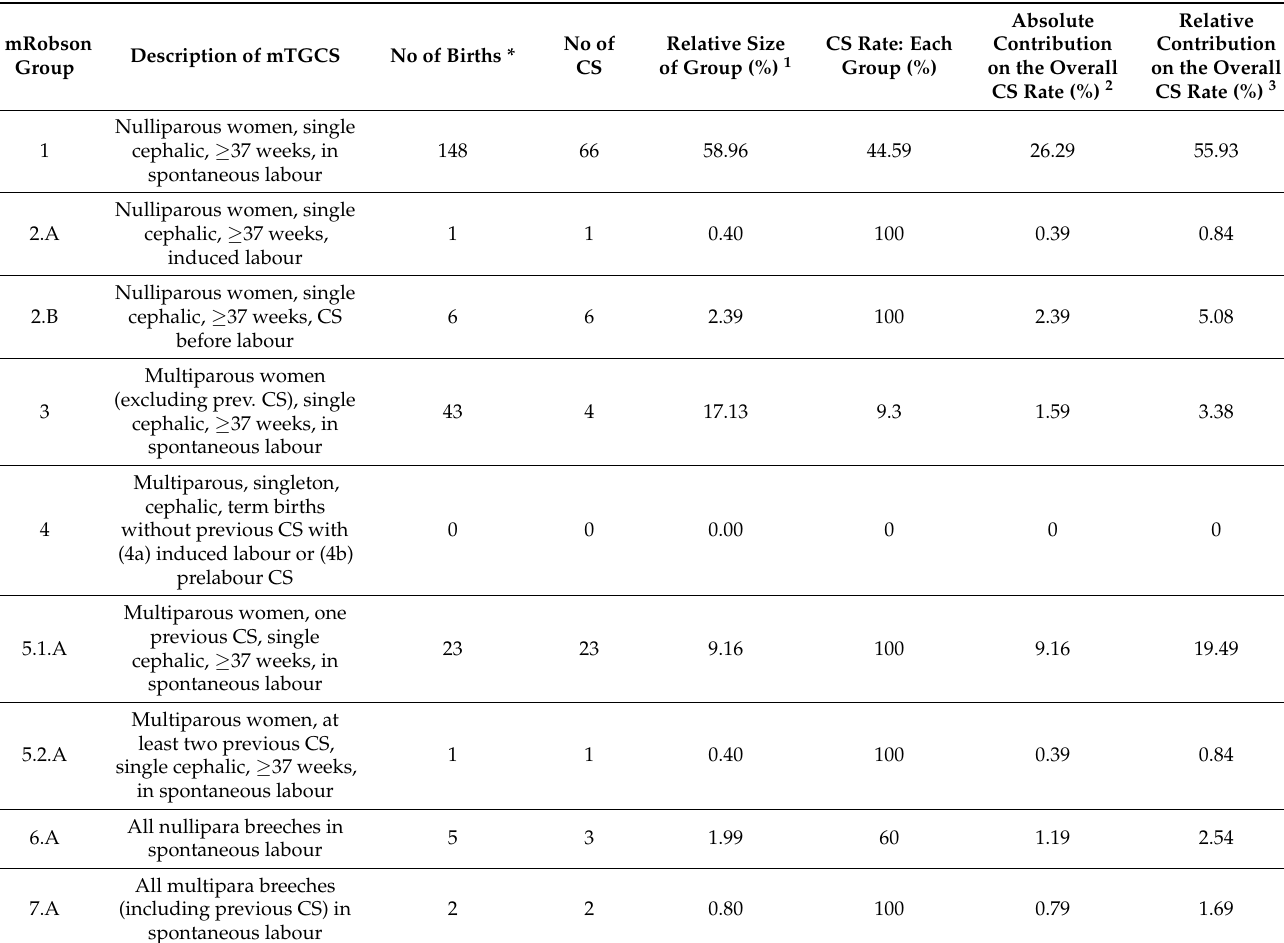
Table 1. Robson mTGCS in the adolescent population who delivered between 1 March 2020 and 1 March 2021 in “St. Pantelimon” Emergency